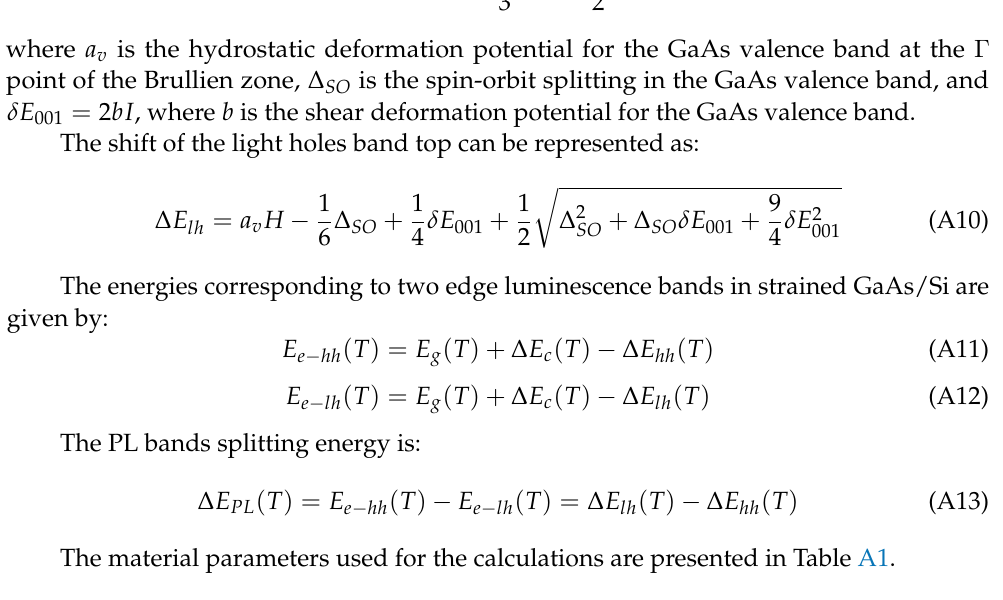
Table A1. Material parameters used in calculations. a GaAs ( 300 K ) —GaAs lattice constant at 300K, α T and α T —linear thermal expansion coefficients of GaAs and Si, C 11 and C 12 —GaAs elastic GaAs Si constants, a c , a v —hydrostatic deformation potentials for the GaAs conduction band and valence band, b —shear deformation potential for the GaAs valence band, ∆ SO is the spin-orbit splitting in the GaAs valence